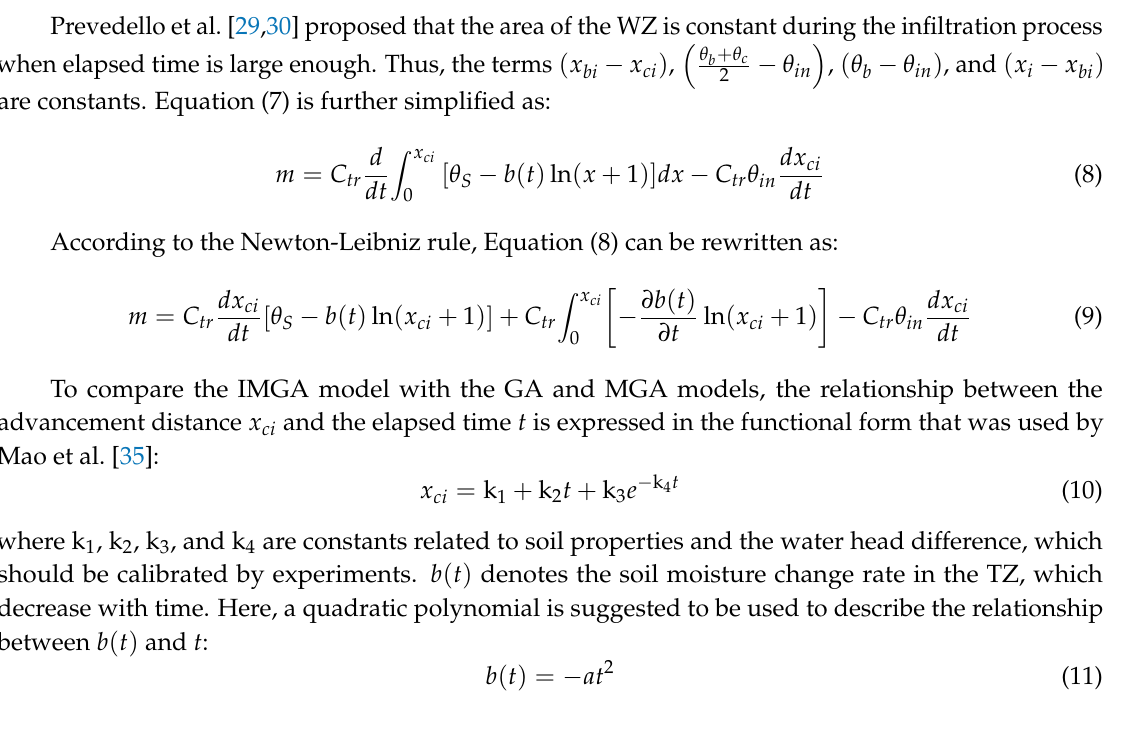
Figure 4. Configuration of the experimental apparatus: ( a ) soil column and cross section of the carbon fiber heated cable (CFHC); ( b ) cut region of the polyvinyl chloride (PVC) tube. During the tests, a distributed moisture sensing (DMS) interrogator (Model No. NZS–DMS–02, Suzhou NanZee Sensing Technology Co., Ltd, Suzhou, China) was used to automatically collect the soil moisture data. The primary performance parameters are shown in Table 1. This interrogator has the integrated functions of heating the CFHC, measuring the distribution of temperature, deducing the soil moisture, and demonstrating the results. The working principle of this interrogator is based